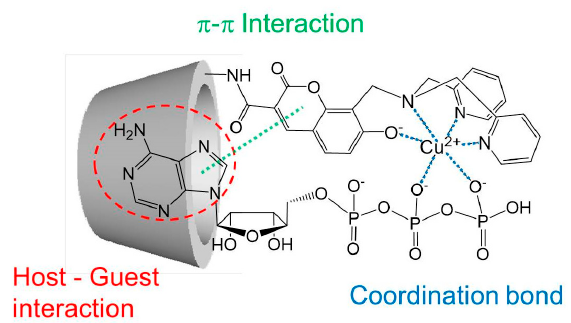
Figure 8. Suggested supramolecular conformation of the ATP/ Cu·1 β complex.